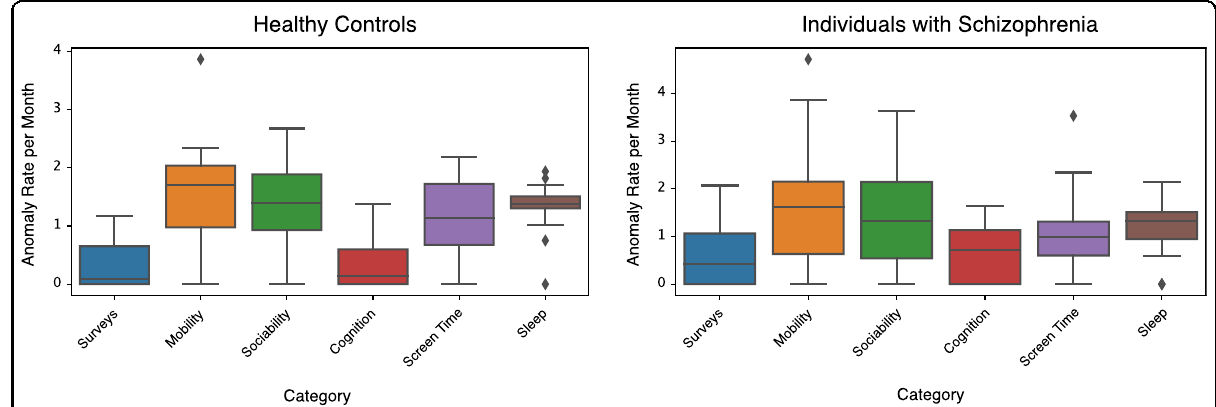
Fig. 1 Box and whisker plots of monthly anomaly rates for each feature, separated by diagnostic group. The box edges represent the 25th and 75th percentiles and a median line is drawn within each box. The whiskers extend to 1.5 times the interquartile range in both directions, and outliers are plotted separately.